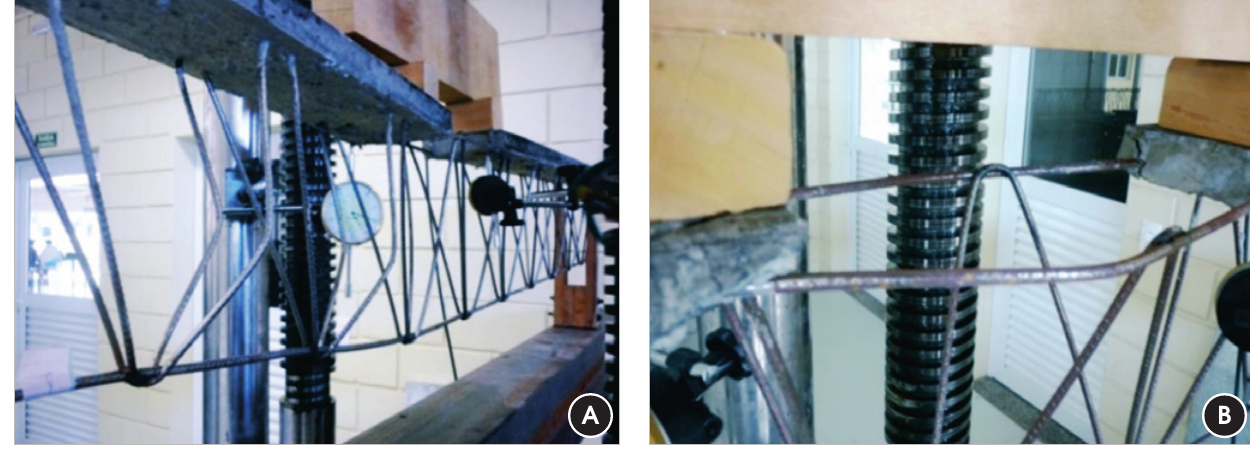
Figure 9 Failure modes: (A) diagonal buckling; (B) lower flange buckling